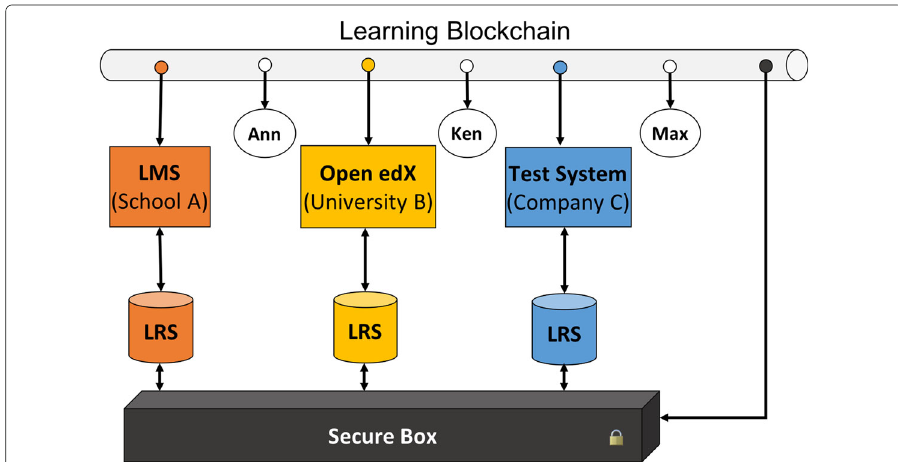
Fig. 2 Proposed design of blockchain of learning logs (BOLL). Our proposed idea of how learning systems should be designed to enable the ability for learners to conveniently and efficiently manage their lifelong learning logs. With one identifier across multiple learning systems, the BOLL system can be used to connect learning records across different